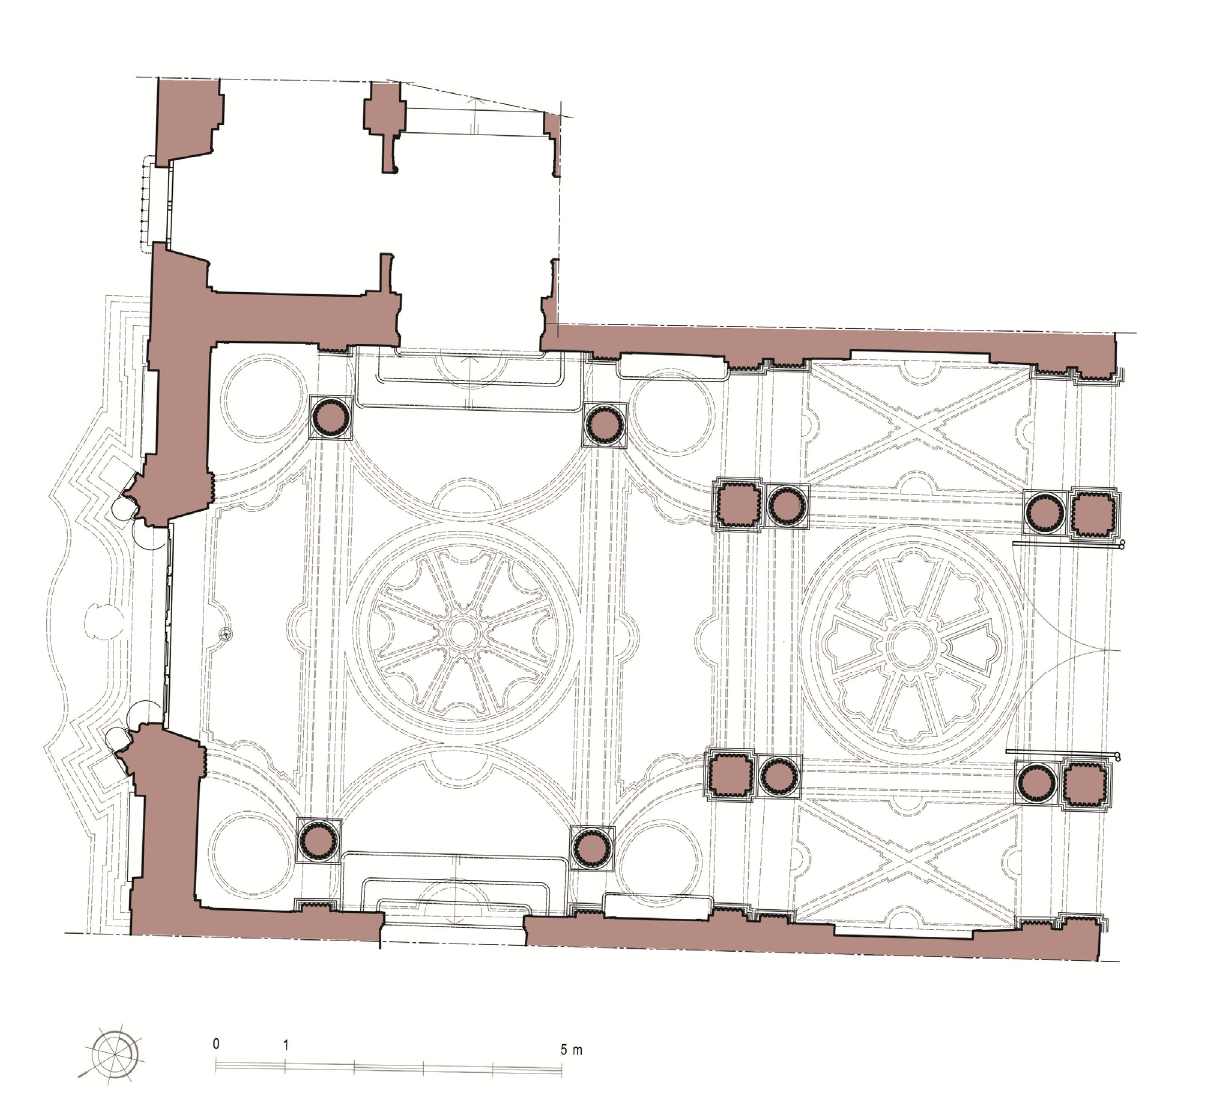
Figure 5 . Plan at 1:50 scale of Palazzo Mazzonis atrium. Drawing: M.